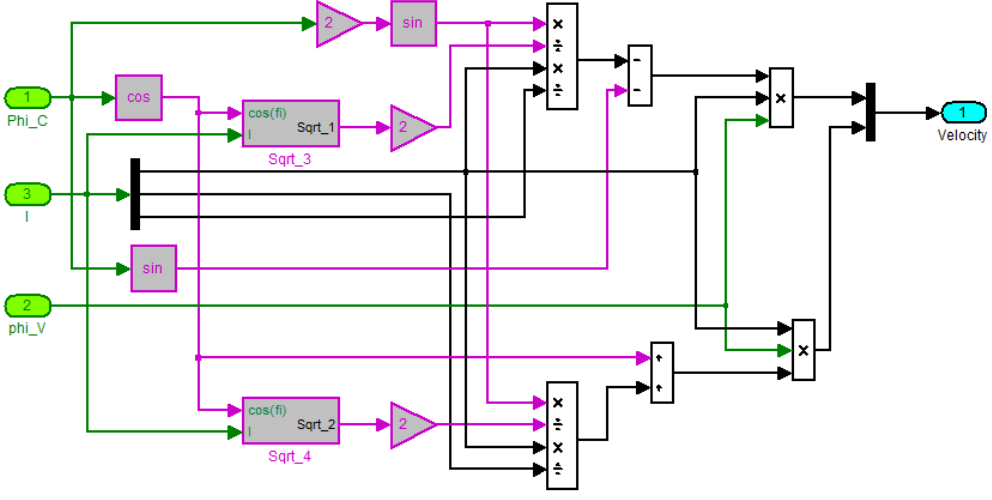
Figure 8. Determination of projection of point C velocity (calculation using Eqs. 2 and 3).